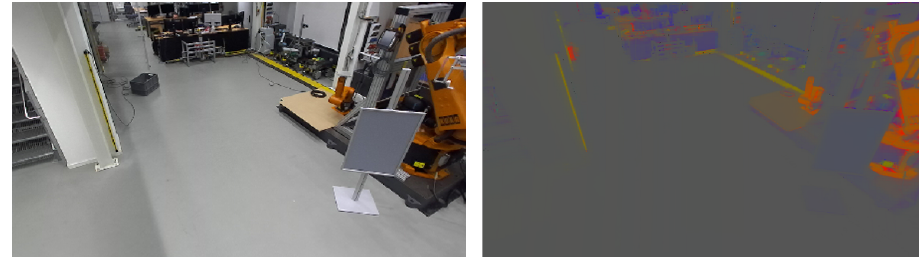
Figure 5. Comparison of RGB image ( left ) and rg chromaticity image ( right ) of the same